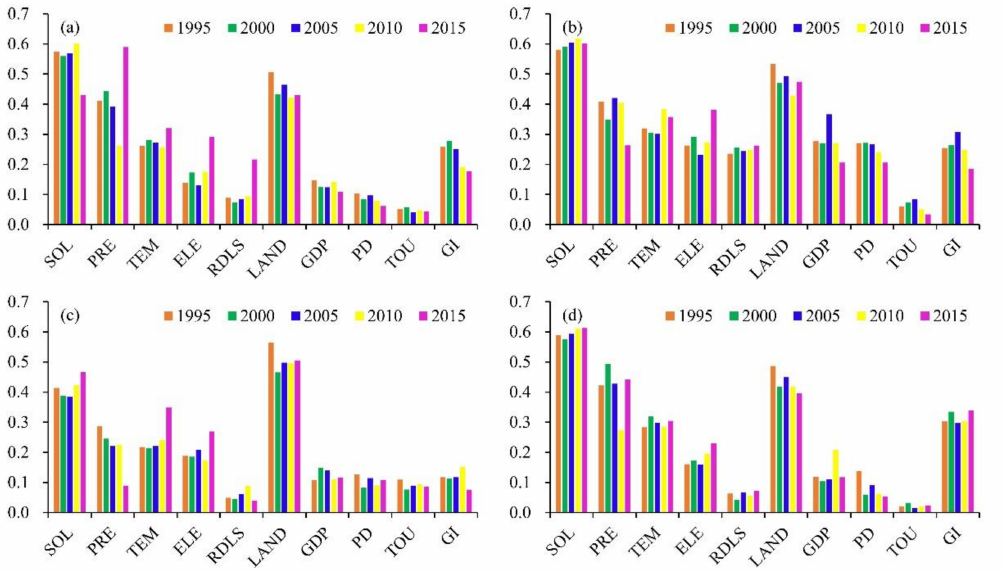
Figure 9. The PD value of each factor from 1995 to 2015: ( a ) the total Tianshan Mountains area, ( b ) the east Tianshan Mountains, ( c ) the north Tianshan Mountains, and ( d ) the middle Tianshan